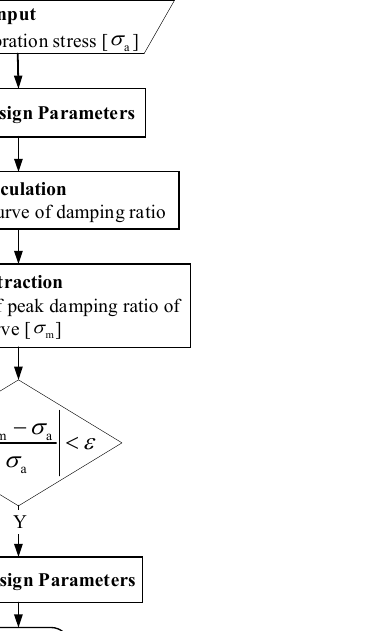
Figure 13. Blisk ‐ ring dry friction system.